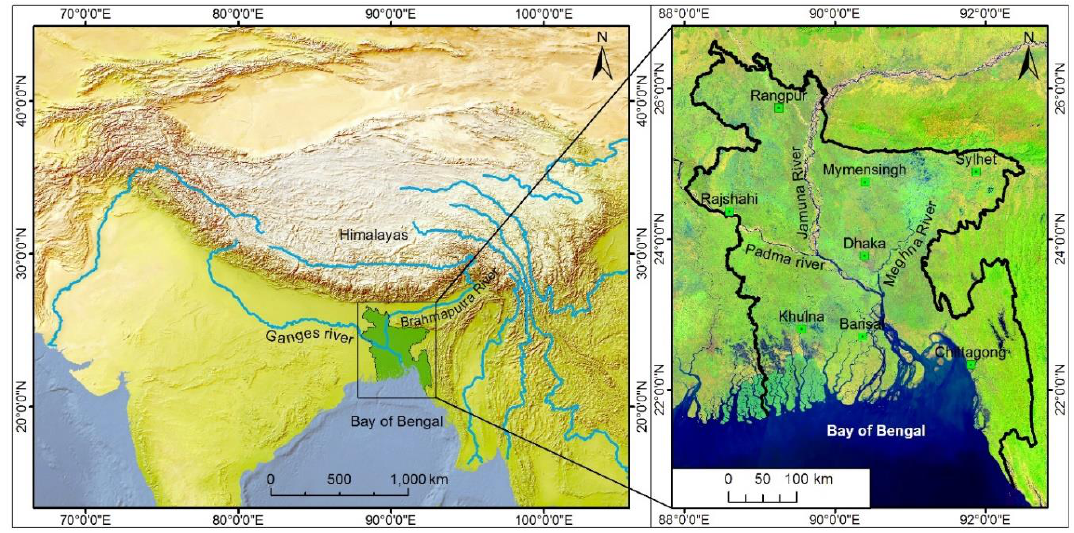
Figure 1. Study area of the entire country of Bangladesh showing three large river systems: The Ganges (Padma), Brahmaputra (Jamuna), and the Meghna forming the largest riverine delta in the